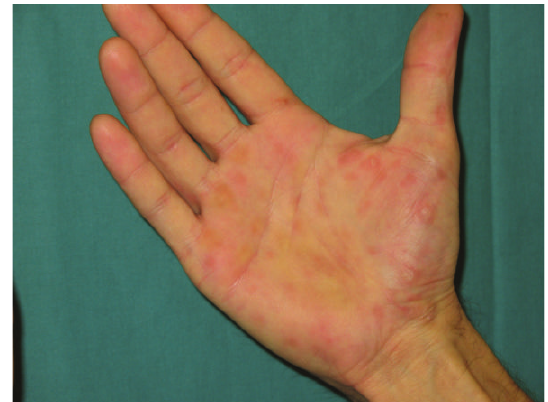
Figure 16: Secondary syphilis.